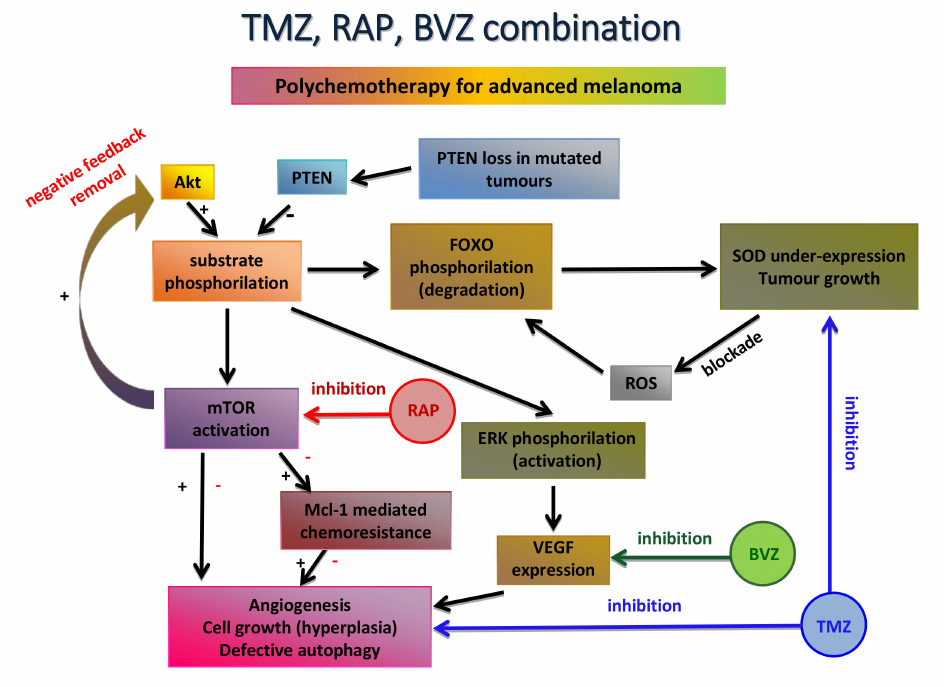
Figure 4. Rationale for melanoma polychemotherapy loaded in nanoemulsions. Abbreviations: Akt: protein kinase B; BVZ: bevacizumab; ERK: extracellular signal-regulated kinases; FOXO: forkhead box O; Mcl-1: Induced myeloid leukemia cell differentiation protein 1; mTOR: mammalian target of rapamycin; PTEN: phosphatase and tensin homolog; RAP: rapamycin; ROS: reactive oxygen species; SOD: superoxide dismutase; TMZ: temozolomide; VEGF: vascular endothelial growth